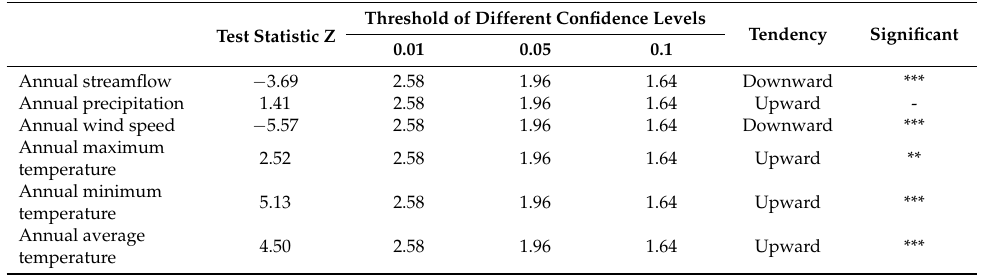
Table 4. Results of temporal trends in annual streamflow, precipitation, wind speed, maximum temperature, minimum temperature and mean temperature of the Hailiutu River basin.